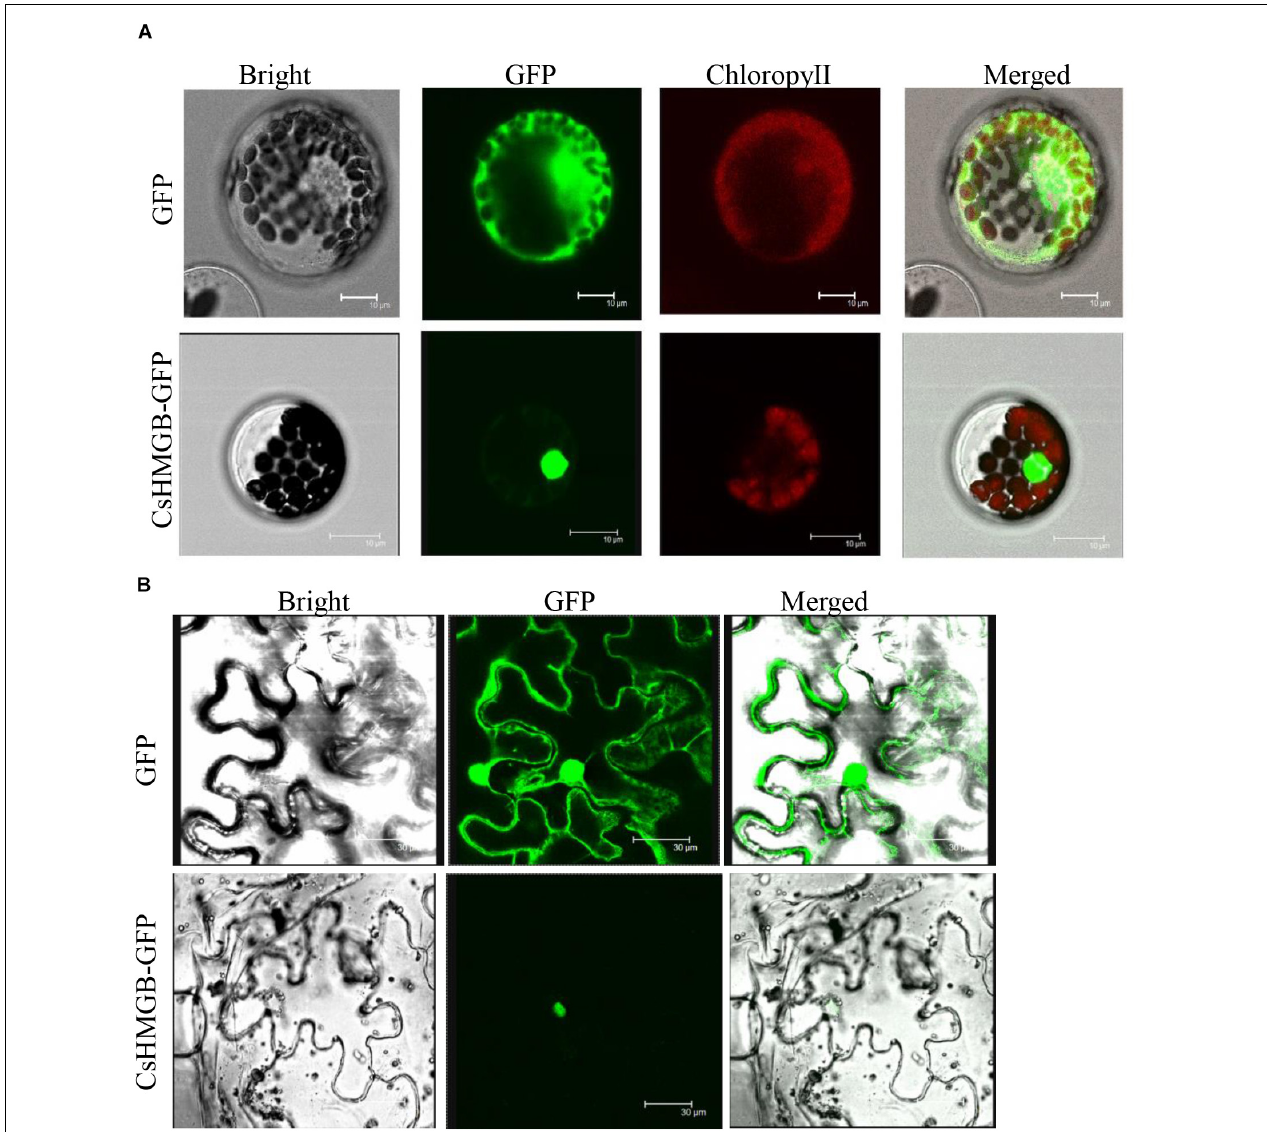
FIGURE 4 | Subcellular localization of CsHMGB protein. (A) Subcellular localization of the CsHMGB protein in Arabidopsis protoplasts. The target protein of CsHMGB-GFP and empty plasmids (GFP) were observed with four channels of white light, UV light, and red light to localize the proteins. Bars of 10 µ m. (B) Subcellular localization of the CsHMGB protein in leaf epidermis of N. benthamiana . Bars of 30 µ m.